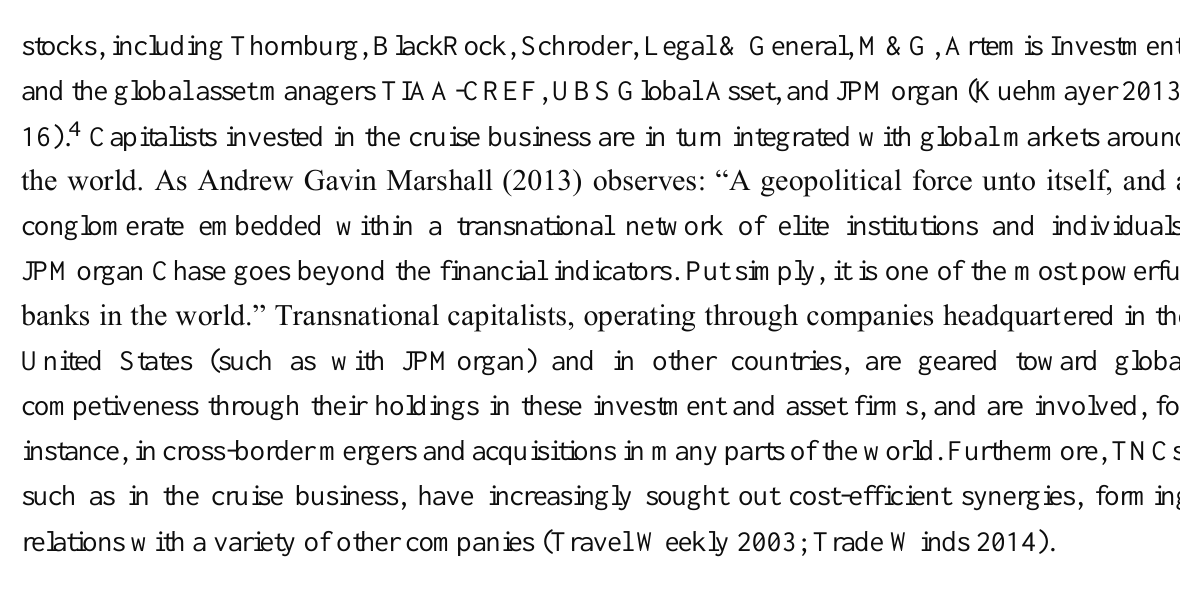
Figure 3. Revenue (millions), Royal Caribbean,